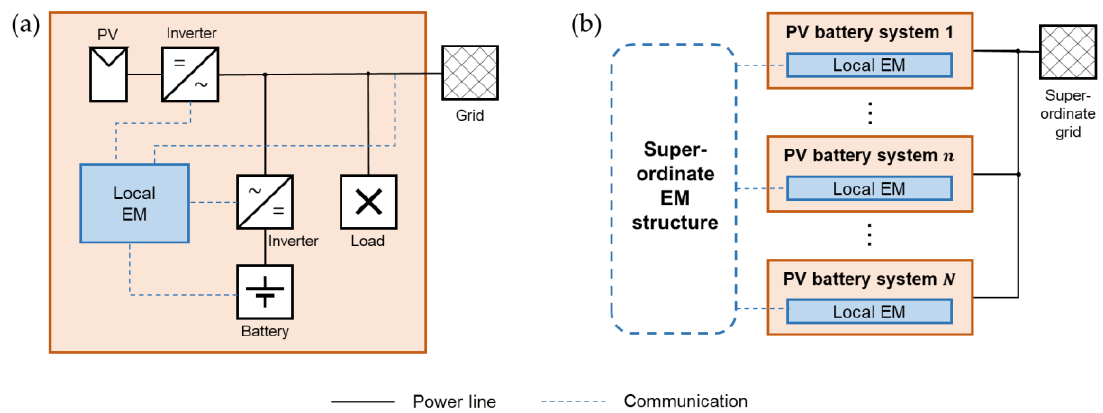
Figure 1. ( a ) Topology of a single PV battery system; ( b ) topology of a neighborhood of N PV battery systems (PV: photovoltaic, EM: energy management).